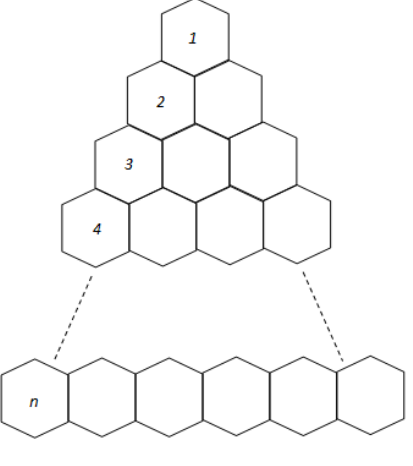
Fig. 1 Molecular graph of triangular benzenoid T ( n )